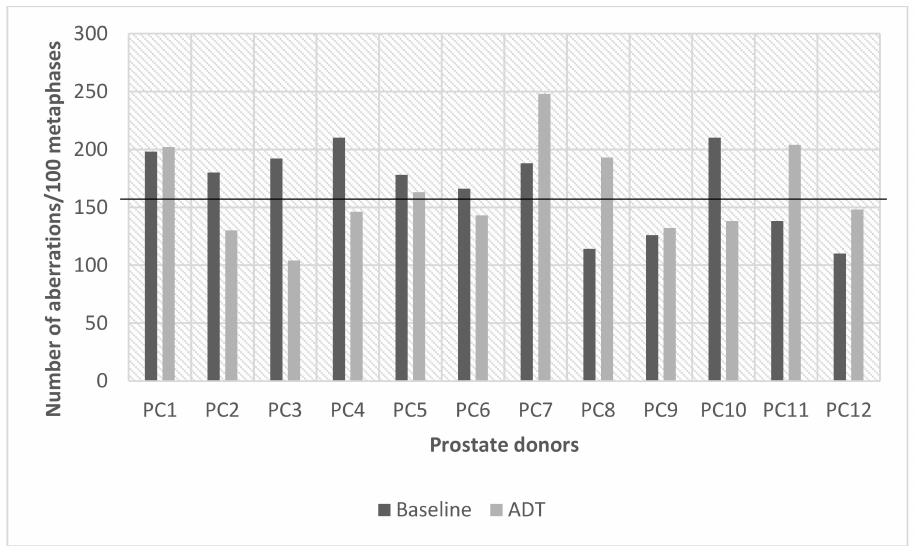
Figure 2. Radiation-induced G2 chromosomal radiosensitivity scores for each prostate cancer donor at baseline compared to ADT for 0.5 Gy IR. The 90th percentile of 152 aberrations/100 metaphases is also displayed as black line traversing all prostate